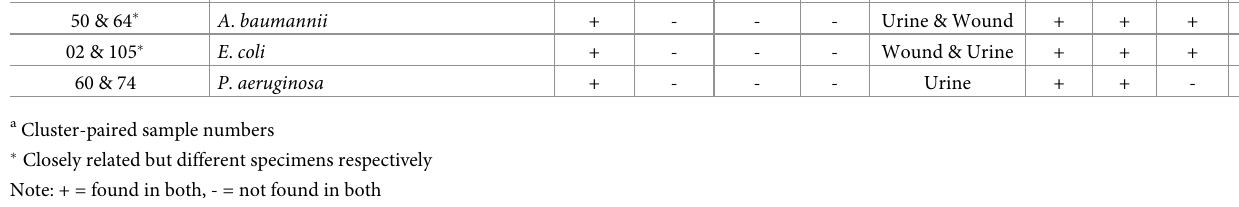
Table 2. Genetic relatedness among the carbapenemase-positive gene carriers. Sample code number a Name of carbapenem- resistant